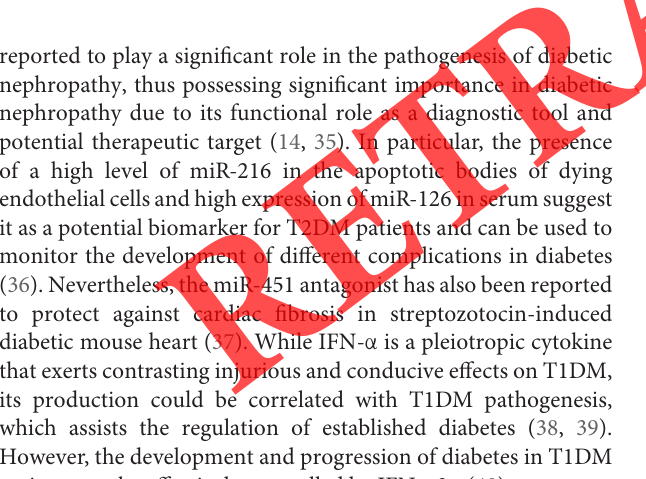
FIGURE 3 | IFN- α 2 is a target gene of miR-216a-3p. (A) Prediction of the miR-216a-3p binding site on the 3 ′ UTR of IFN- α 2 by TargetScan; (B) relative luciferase activity of IFN- α 2-wt and IFN- α 2-mut from a dual-luciferase reporter gene assay; * p < 0.05 vs. the NC group. The measurement data were presented by the mean ± standard deviation. The experiment was repeated three times. One-way ANOVA was used for comparisons among multiple groups followed by Tukey’s post-hoc test. UTR, untranslated region; IFN, interferon; Mut, mutant; Wt, wild